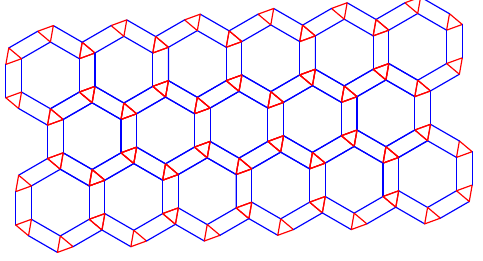
Fig. 27: Tiling with regular triangle, hexagon and two equal